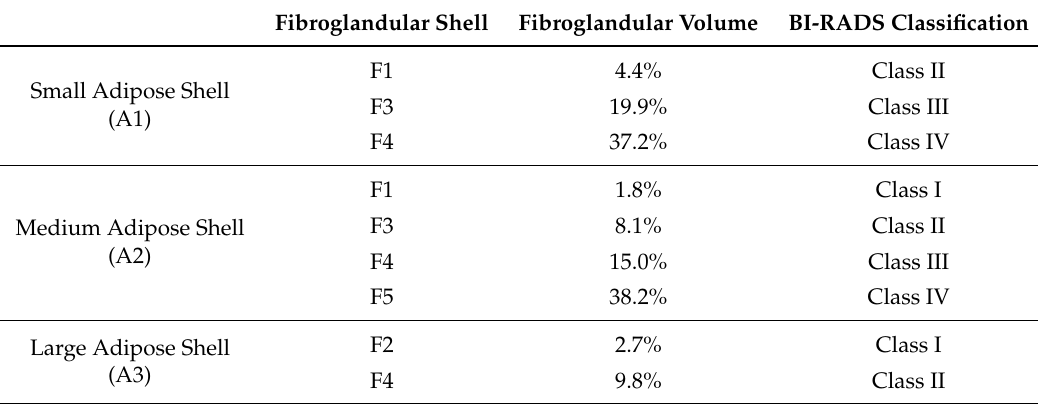
Table 1. Breast density and BI-RADS classifications of phantom combinations used in this